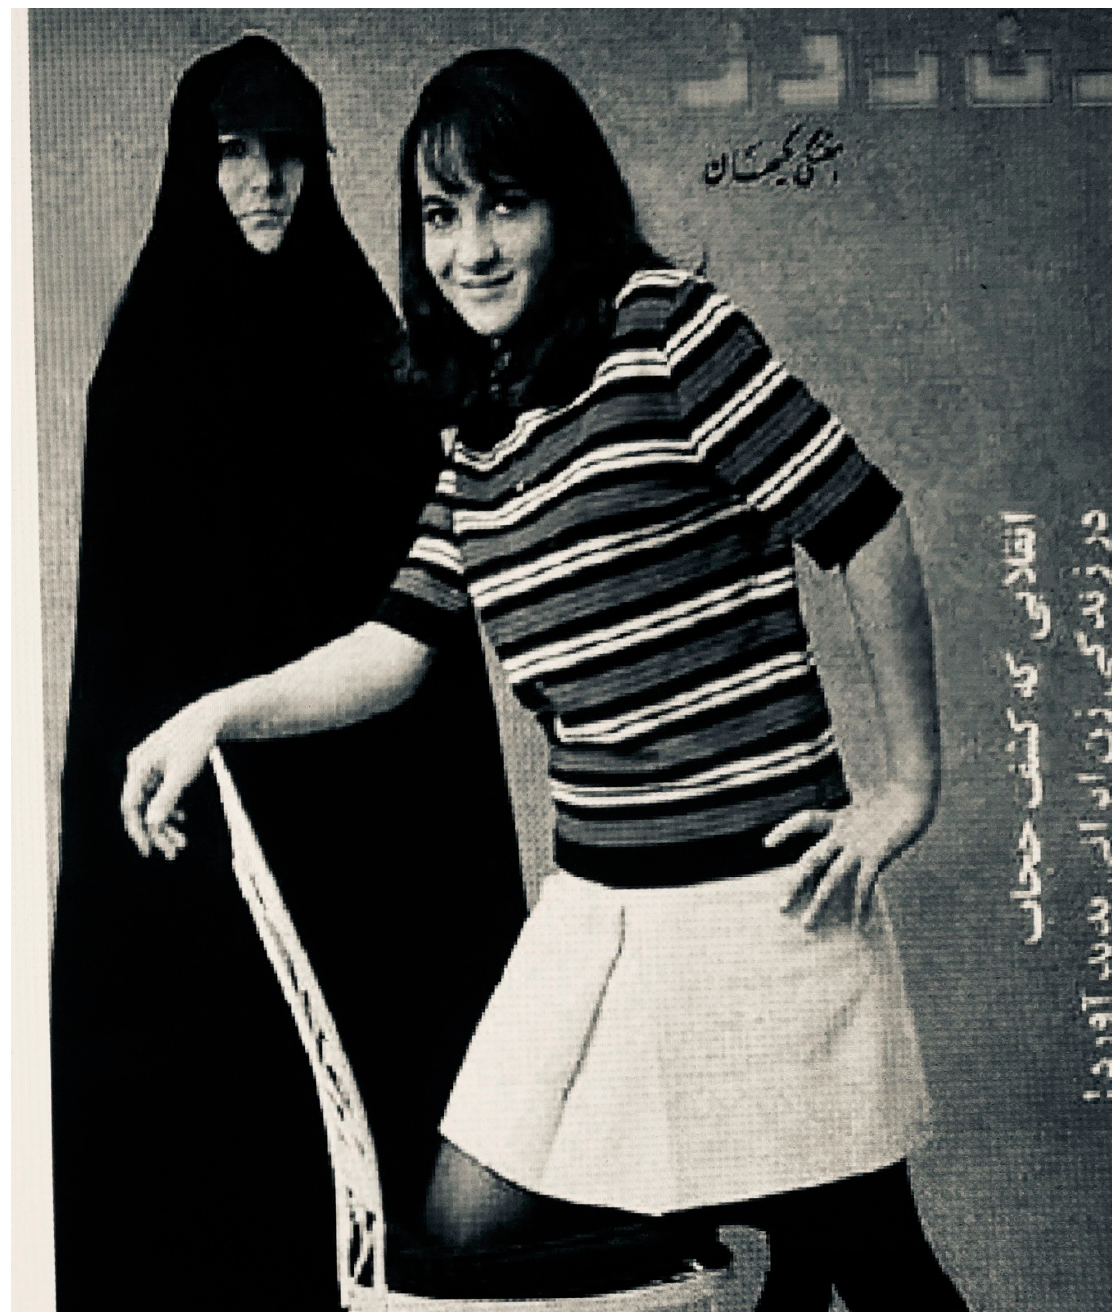
Figure 6. Cover of Zan e Rooz (Today’s Woman) Magazine 1970s. Source for images 3–6: http://www.parstimes.com/fashion/pre_revolution/.